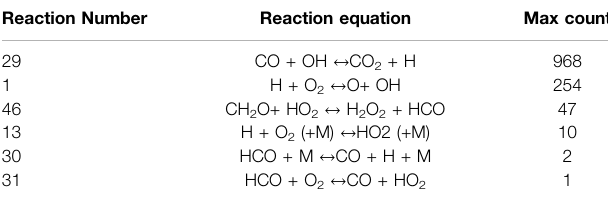
TABLE 3 | Reactions that appear in Figure 5 , including the number of conditions where the fl ame speed is most sensitive to each reaction. Reaction